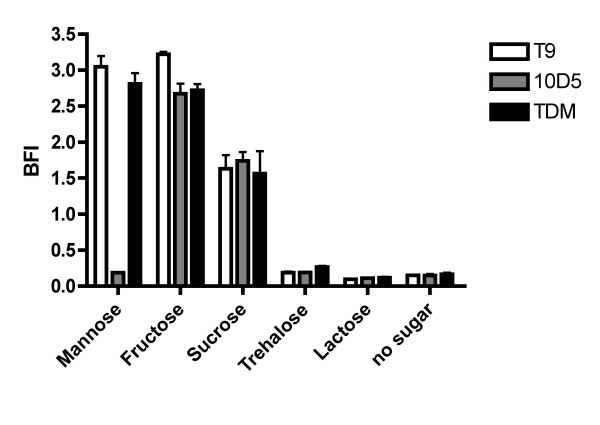
Biofilm formation of the wild-type and the two mutant strains in medium containing various sugars. Addition of mannose and resulted in no biofilm production by the transposon mutant and strong biofilm production by the wild-type and the deletion mutant TDM. All strains produced strong biofilm when 1% fructose was added to the medium. Biofilm formation was reduced in 1% sucrose fro all strains and no biofilm was seen in medium containing trehalose or lactose.